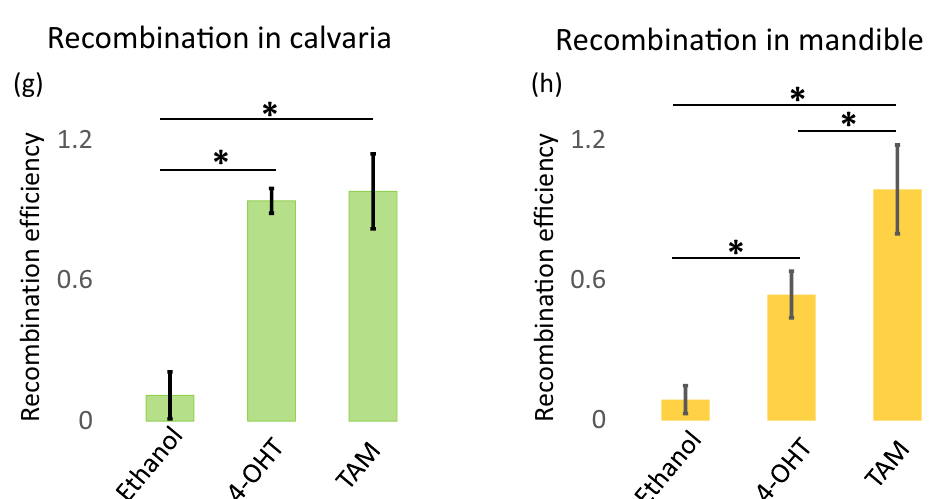
Figure 2. Comparison of recombination efficiency between locally induced and systemically induced recombination. Animals were treated with 4% ethanol (subperiosteal local injection) or 10 µg of 4-OHT (subperiosteal local injection) or 200 µg of Tamoxifen (systemic intraperitoneal (IP) injection). Representative images of the animal’s calvaria and mandibular bones are displayed: ( a ) and ( d ) 4% ethanol local injection, ( b ) and ( e ) 10 µg 4-OHT local injection, and ( c ) and ( f ) IP injections of 200 µg Tamoxifen (TAM). The Prx1 (eGFP) expressing cells are shown in green, the tdTomato expressing cells are shown in red and, thus, the eGFP and tdTomato co-expressing cells are shown in yellow. Bone is visualized with second harmonic generation and is pseudo-colored in blue. The scale bar represents 100 µm. The recombination efficiency measured in the different treatment groups is shown in histograms reporting the data collected in the animals’ calvaria ( g ) and the data collected in the animals’ mandibles ( h ). The error bars indicate standard deviations and the * indicates statistically significant difference with a p value < 0.05 (n =